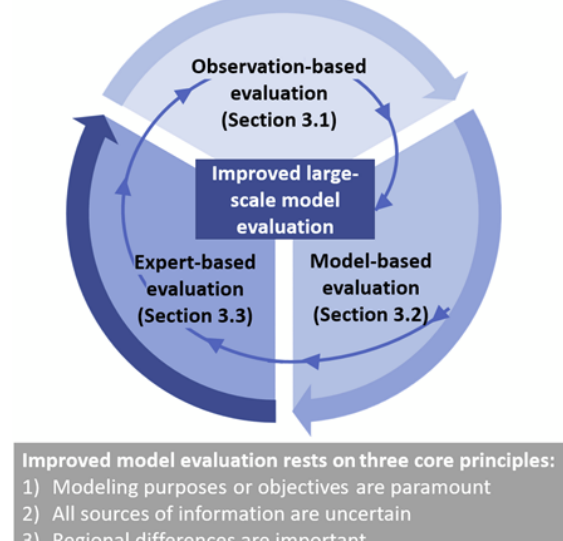
Figure 1. Improved large-scale model evaluation rests on observation-, model-, and expert-based model evaluation. We ar- gue that each strategy is essential so that all three should simulta- neously be pursued by the scientific community. The three strate- gies of model evaluation all rest on three core principles related to (1) model objectives, (2) uncertainty, and (3) regional